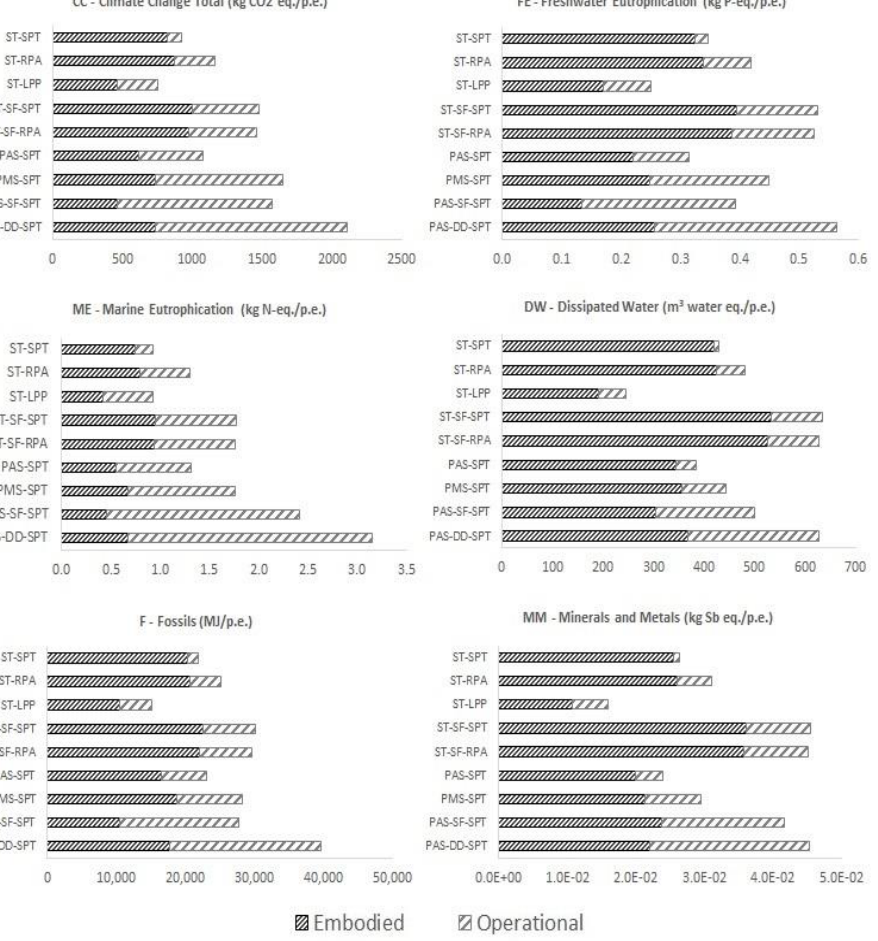
Figure 2. Breakdown of the cumulative environmental impacts for each DWTTS as embodied and operational burdens over a 30-year lifespan (Tables A4 and A5 in Appendix C provide the breakdown of embodied and operational burdens for each DWWTS).